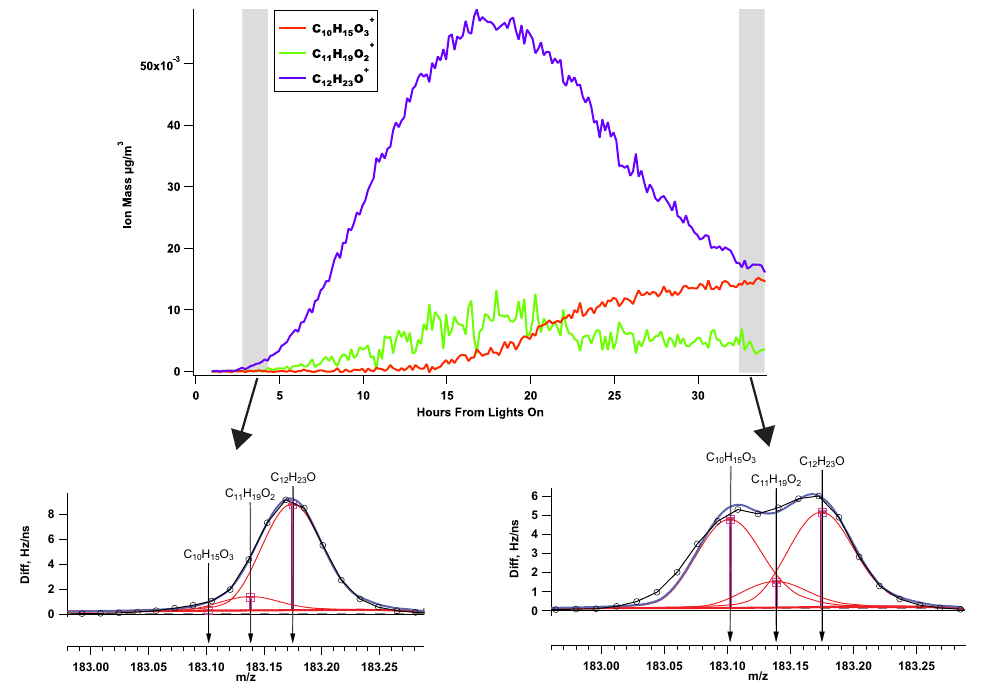
Fig. 3. Time series of ions and the raw data for “early growth” and “most oxidized growth” for m/z 183.